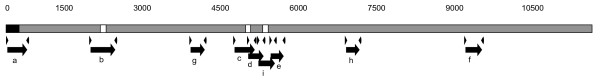
Map showing positions of oligonucleotide PCR primers for gene AAEL004181 and the positions of introns (white boxes) present in the Aedes aegypti Vectorbase annotation for this gene (see Table 1 for primer sequences, product sizes and conditions used in the study). The black box represents an extension of the gene compared to the annotation in Vectorbase. Primers AAEL004181b, c and i were designed to span these introns produced RT-PCR products identical in size to those produced by genomic PCR, confirming that the introns were in fact mis-annotations; RT-PCR using AAEL004181a extended the 5' end of the exon.